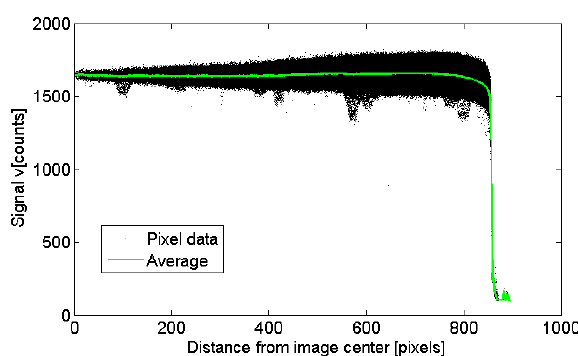
Figure A1. Uniformity of signal values vs. pixel distance from cen- ter, taken from 12 images with USI 1.7 under a Labsphere integrat- ing sphere (LIS). In the LIS pixel signal should be homogeneous.